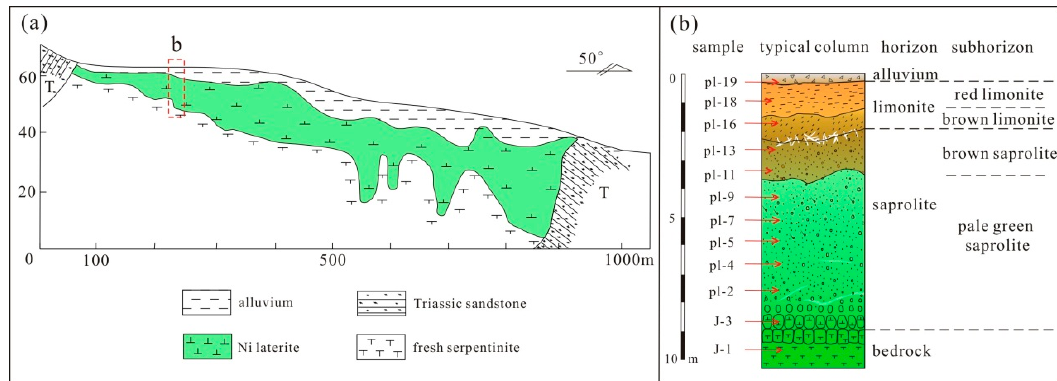
Figure 3. The typical long cross-section ( a ) and vertical column ( b ) of the Ni laterite profile from the study site at the Yuanjiang area, including the location of the samples.